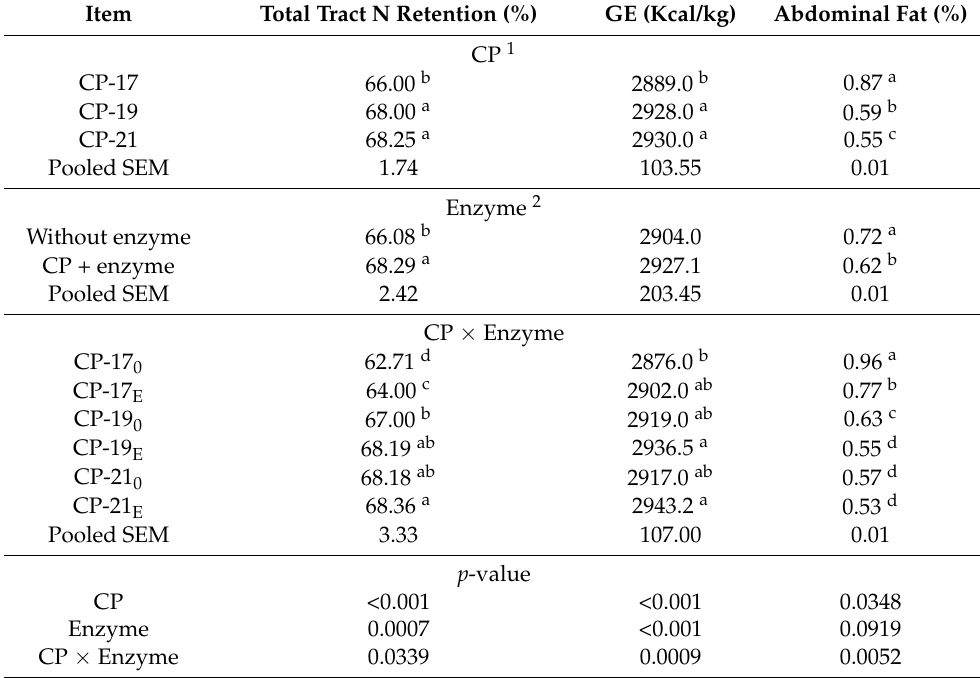
Table 3. Total tract N retention, gross energy (GE) and abdominal fat of broilers fed different levels of crude protein and protease enzyme over 15–28